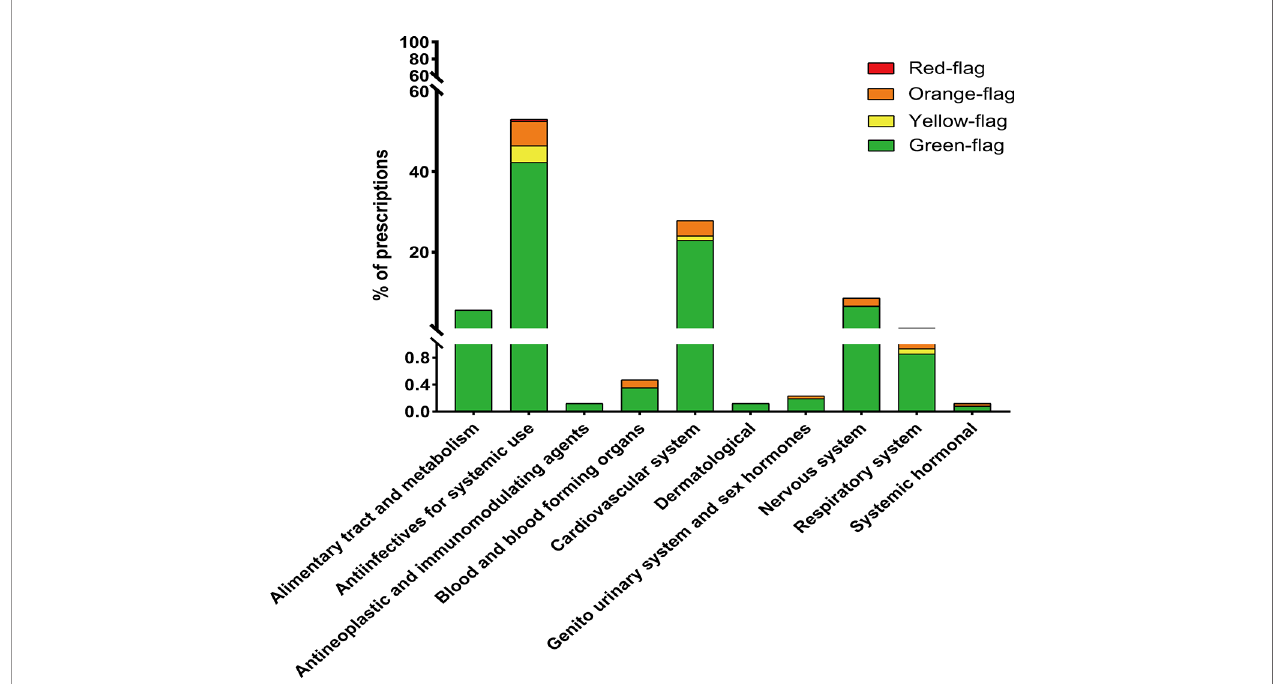
FIGURE 2 | Co-medications sorted according to the anatomical therapeutic chemical classi fi cation system and prevalence of DDIs within each therapeutic